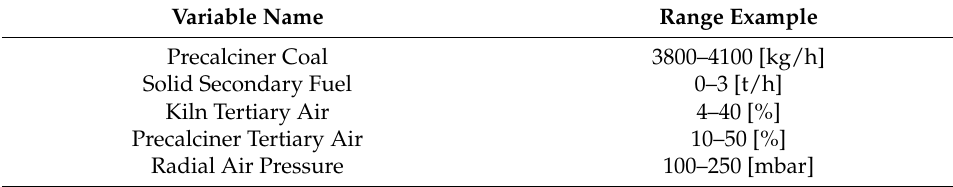
Table 2. Rotary kiln APC system: DVs.